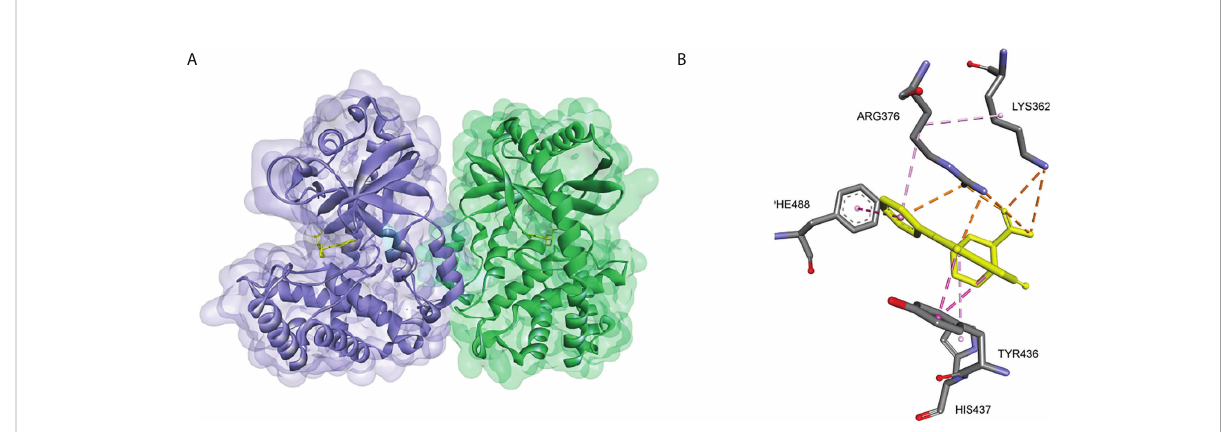
FIGURE 9 (A) Crystal structure of the cGAS inhibitor PF-06928215 bound to a cGAS dimer (PDB-ID: 4LRC); (B) Residues of the cGAS active center interacting with PF-06928215 and the interactions (PDB-ID: